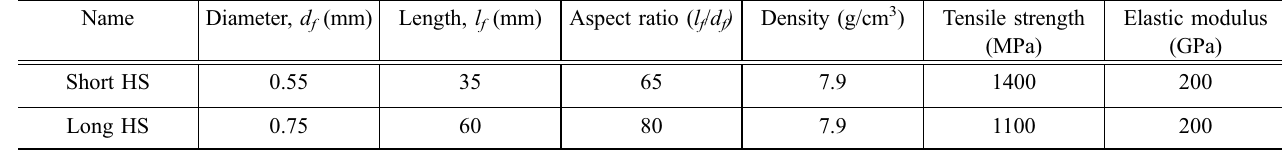
Table 4 Properties of hooked steel